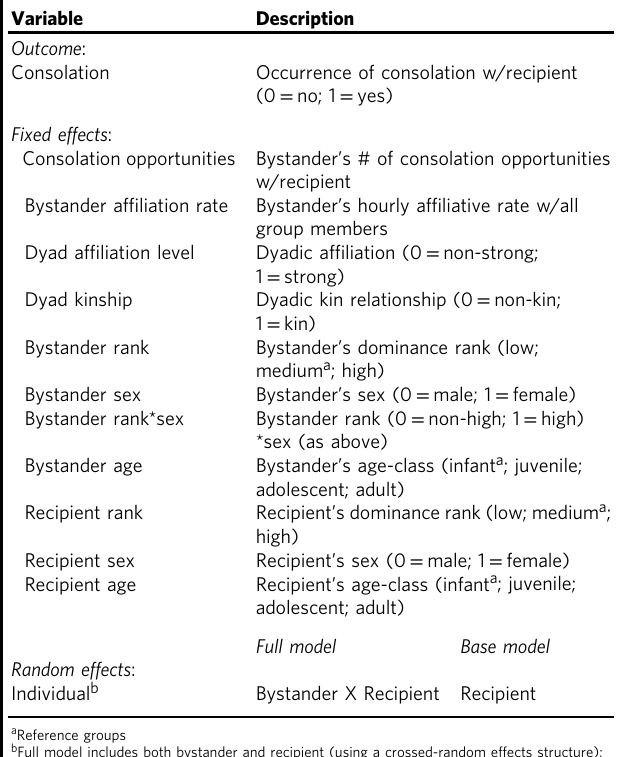
Table 2 GLMM for individual differences in